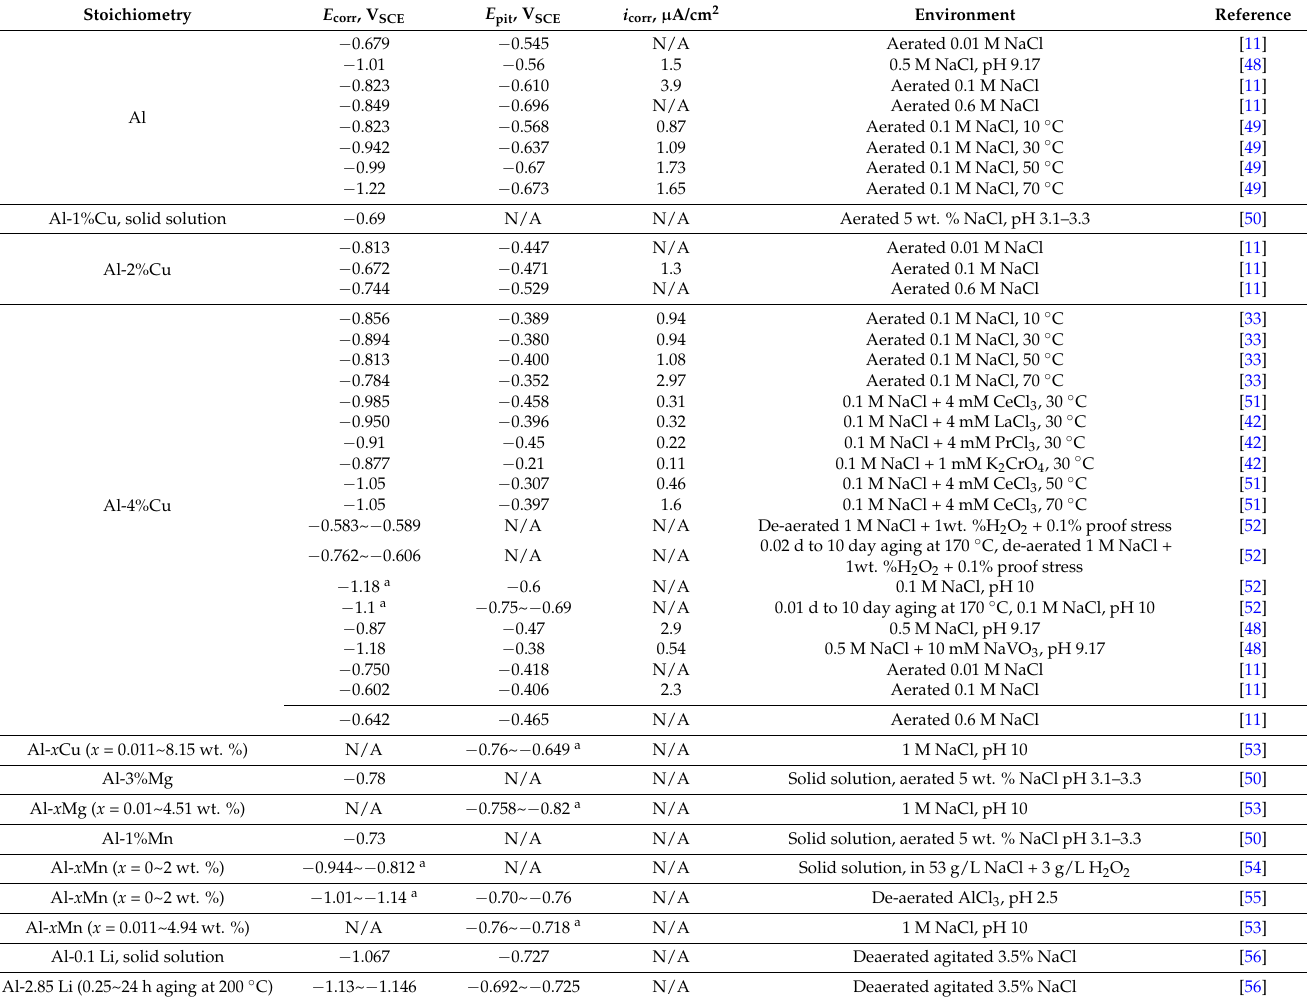
Table 1. Corrosion potential, pitting potential and corrosion current density of Al-rich solid solution and second phase particles. Stoichiometry